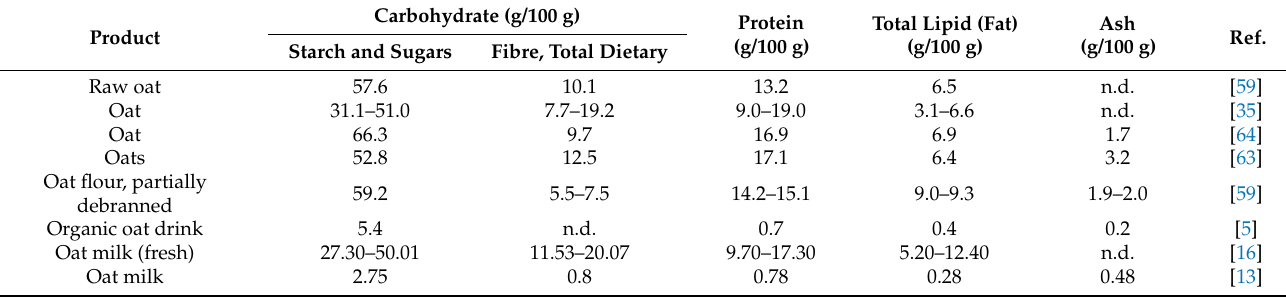
Table 2. Basic ingredients of oat product per 100